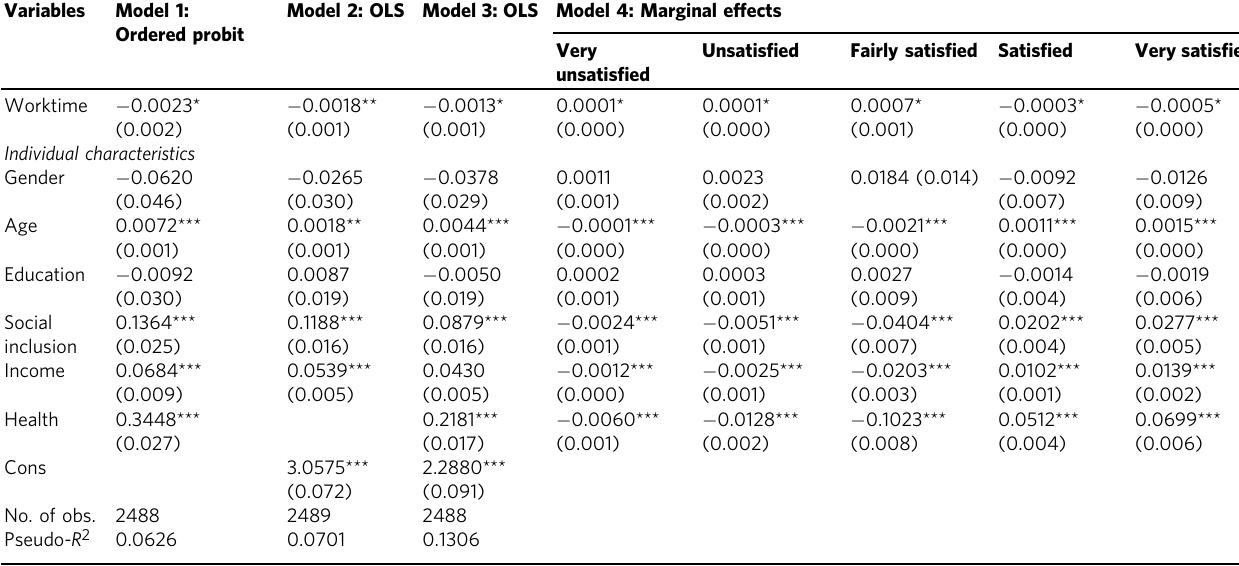
Table 1 Effect of worktime per week on self-reported life satisfaction using ordered probit model and the marginal effects. Variables Model 1: Model 2: OLS Model 3: OLS Model 4: Marginal Ordered probit